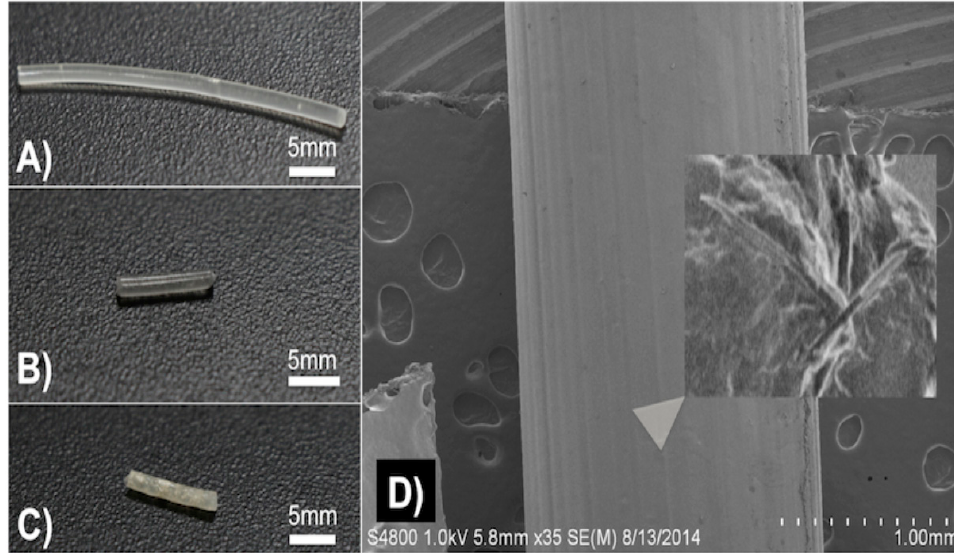
Figure 2. ( A ) 7.5 wt % HNT loaded with gentamicin PLA filament; ( B ) 1.5 wt % HNT loaded with gentamicin PLA filament; ( C ) 10 wt % HNT PLA filament; ( D ) SEM 1.5 wt % HNT loaded with gentamicin filament. Insert magnifies the filament surface in D to show GS flakes.